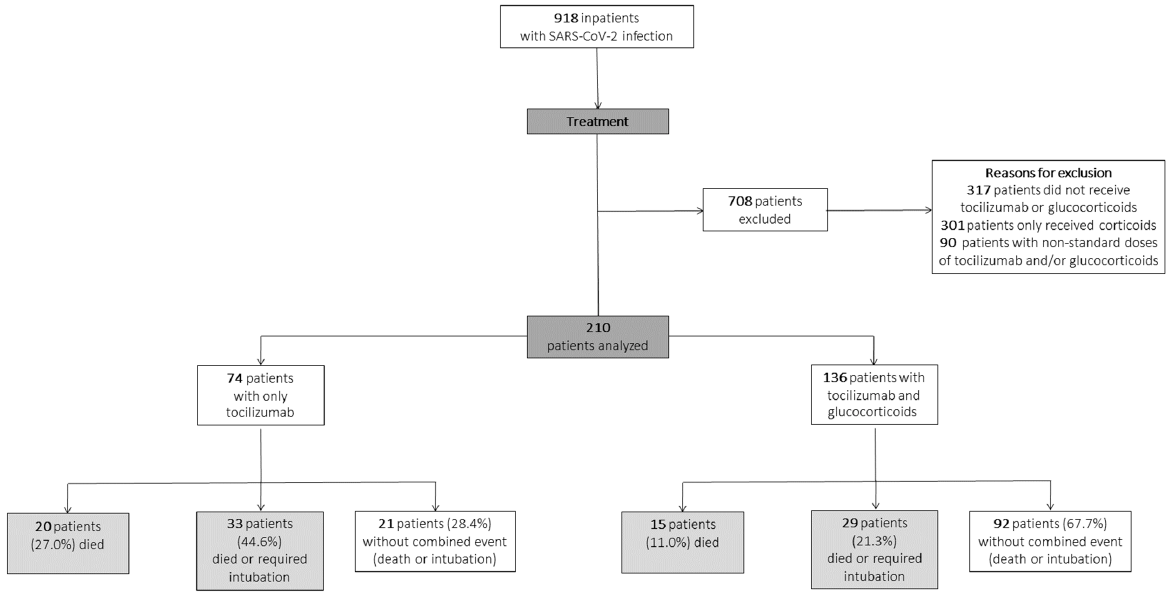
Figure 1. Flowchart of patient selection according to hospital protocol. Patients were included in the tocilizumab and glucocorticoid group if they received at least 125 mg of intravenous methylprednisolone (or dexamethasone equivalent) for 2 to 5 days and one or two doses of intravenous tocilizumab.